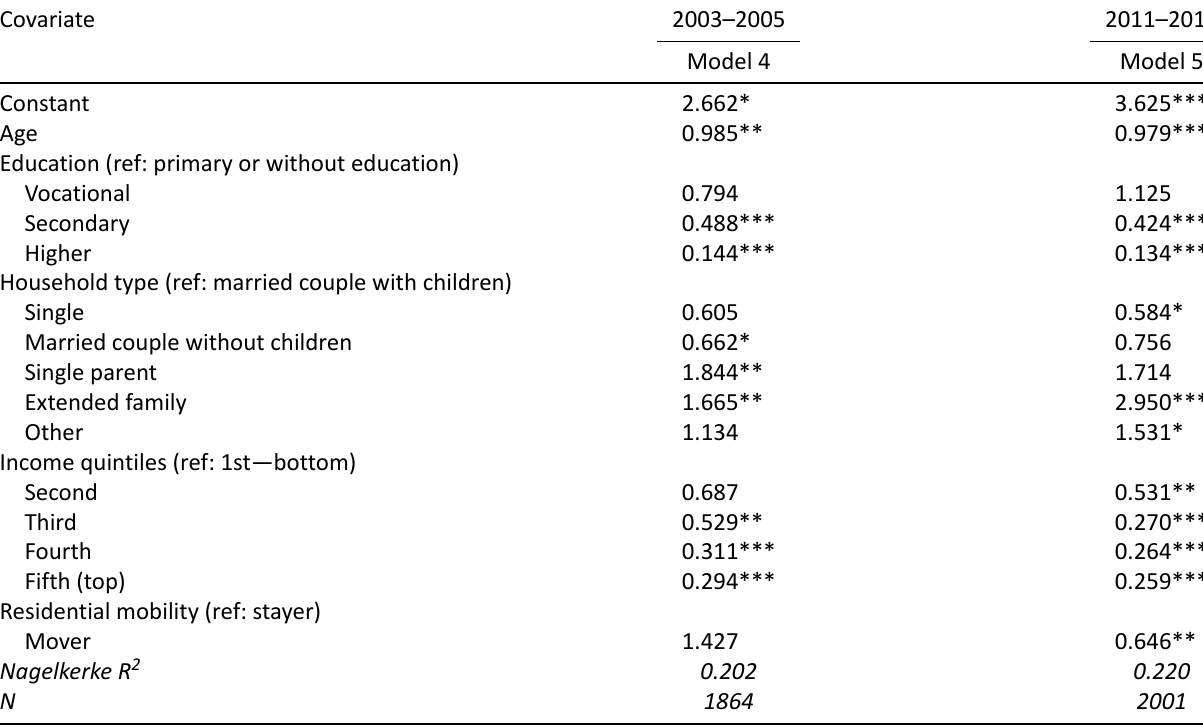
Table 3. Binominal logistic regression models on reliance on public housing, Lodz 2003–2005 and 2011–2013.